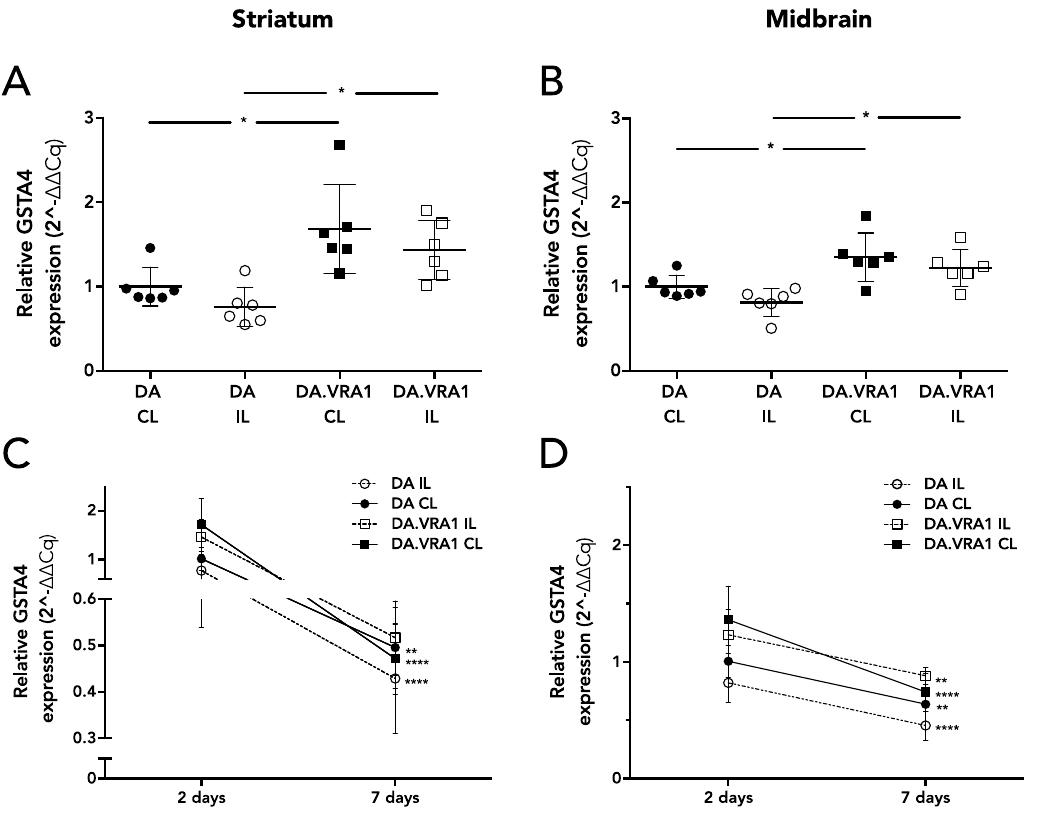
Figure 3. Gsta4 gene expression in the striatum and midbrain after striatal 6-OHDA lesion. At 2 days post lesion, Gsta4 expression is significantly higher in DA.VRA1 compared to DA for both the ipsilateral and the contralateral sides of the striatum ( A ) and midbrain ( B ). Gsta4 expression levels in the striatum ( C ) and midbrain ( D ) are higher at 2 days compared to 7 days post lesion in both strains. p values relate to the comparisons between 2 and 7 days for each specific strain and side. Gene expression levels are related to the mean value for DA at the IL side. * p < 0.05 for ( A ) and ( B ) based on a one-way ANOVA, mean ± SD are shown. ** p < 0.01, **** p < 0.0001 for ( C ) and ( D ) based on a two-way ANOVA. (DA = Dark Agouti; DA.VRA1 = Vra1 congenic; CL = Controlateral; IL =